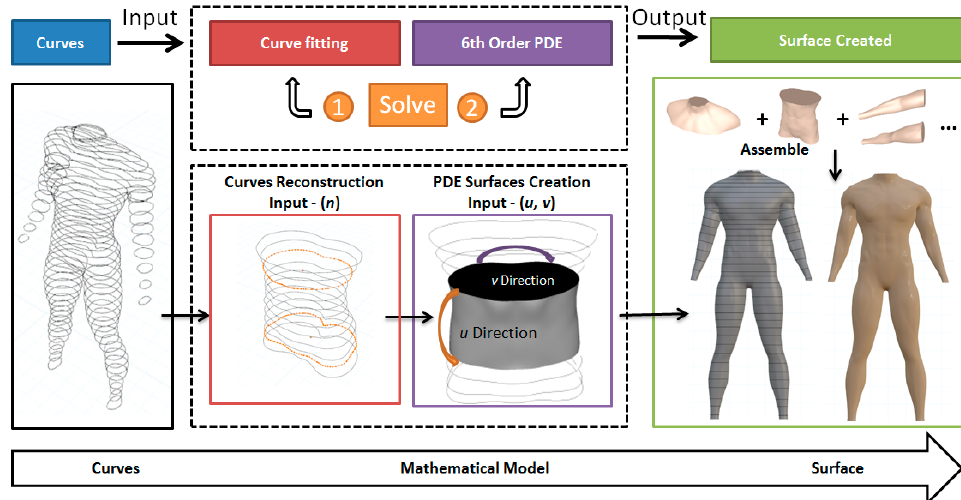
Figure 2. Overall proposed